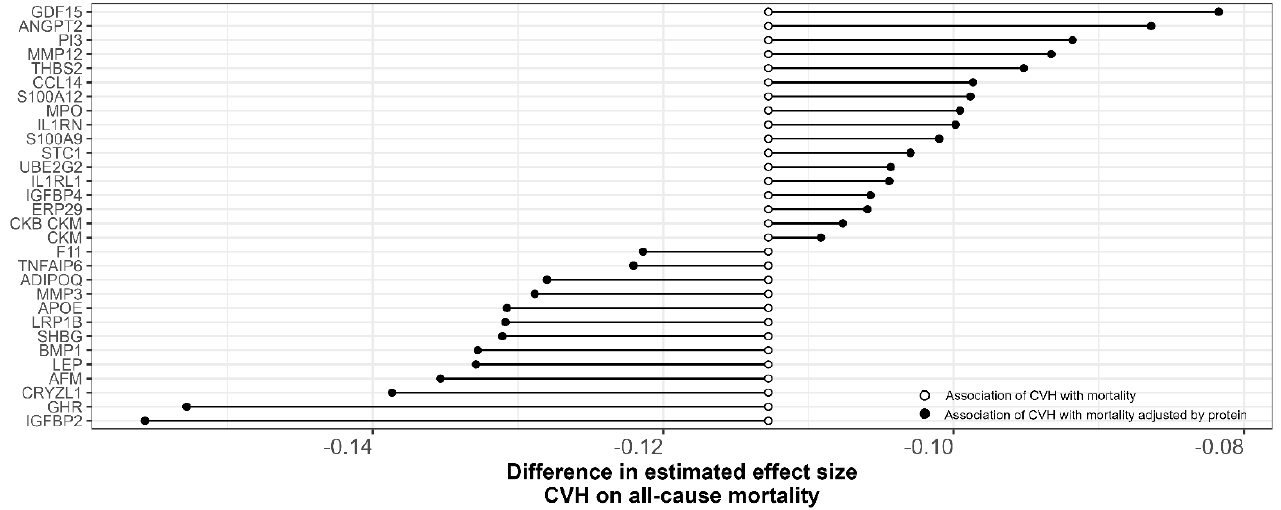
Figure 2. The mediating effect of individual plasma protein on the relationship between CVH and all-cause mortality. Higher CVH was negatively associated with all-cause mortality (white circle). Inclusion of individual plasma proteins significantly changed the magnitude of association (black circle), reflecting the mediation effect. Of the 92 CVH associated proteins, 33 proteins significantly mediated the relationship between CVH and all-cause mortality.